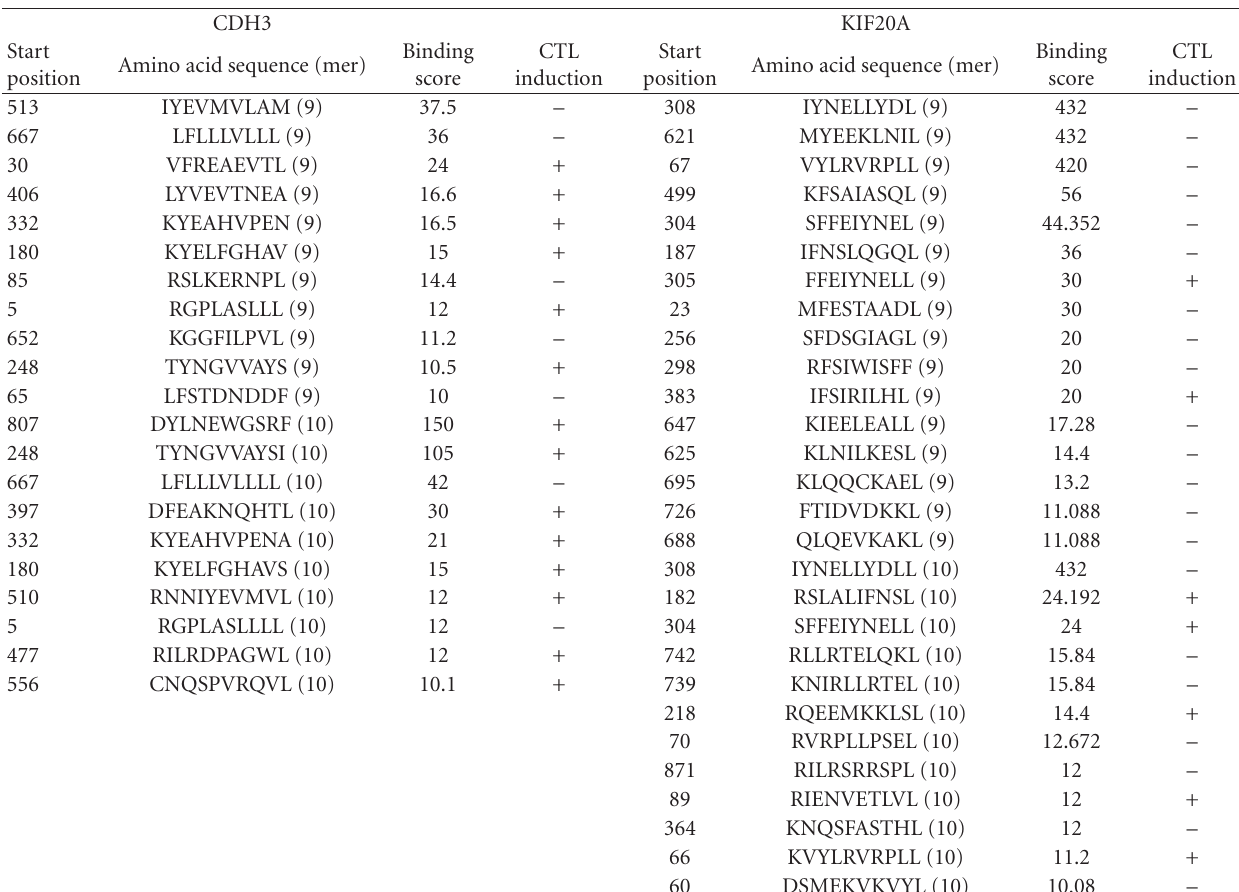
Table 1: Candidates of epitope peptide derived from CDH3 and